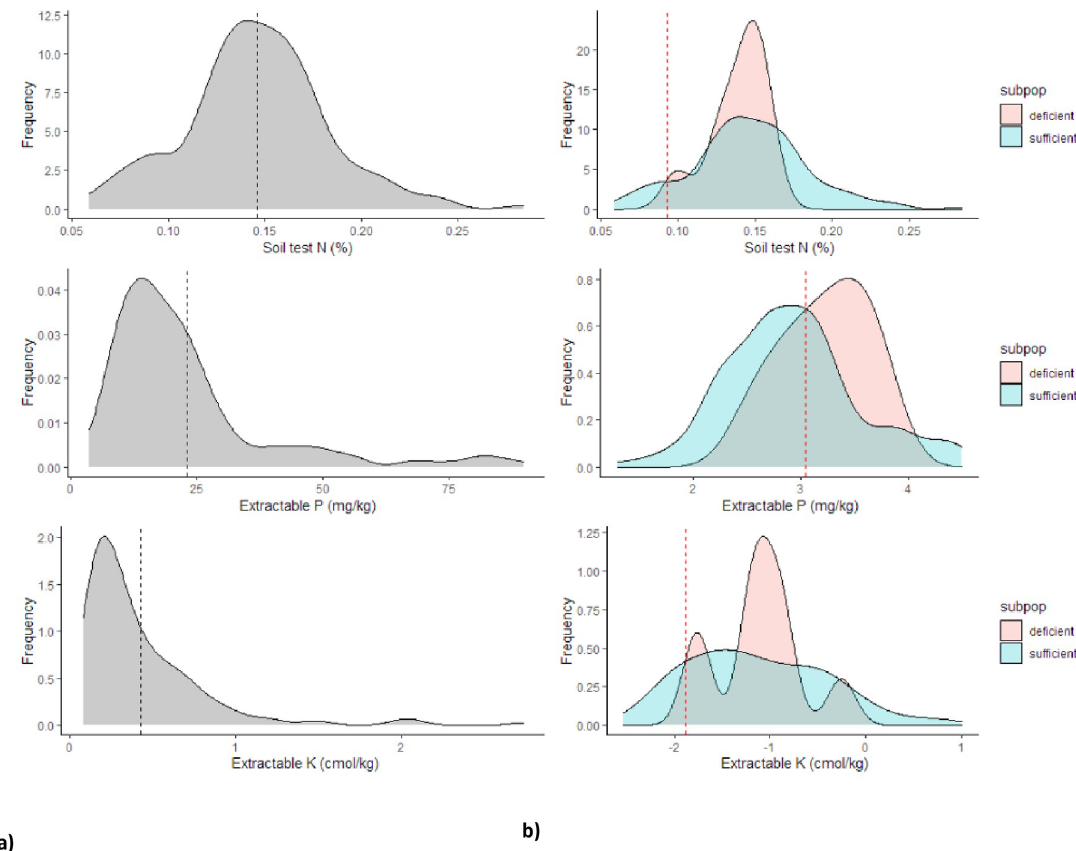
Fig 7. Density plots for soil test values a ) for nitrogen, c ) for phosphorus and e ) potassium with corresponding to frequency distribution plot of “ deficient ” and “ sufficient ” sub-population for establishing localized soil cut-off values for b ) nitrogen, d ) for phosphorus, and f ) potassium. The dashed red lines represent the soil cut off values, while the black one represents the mean soil test values of target